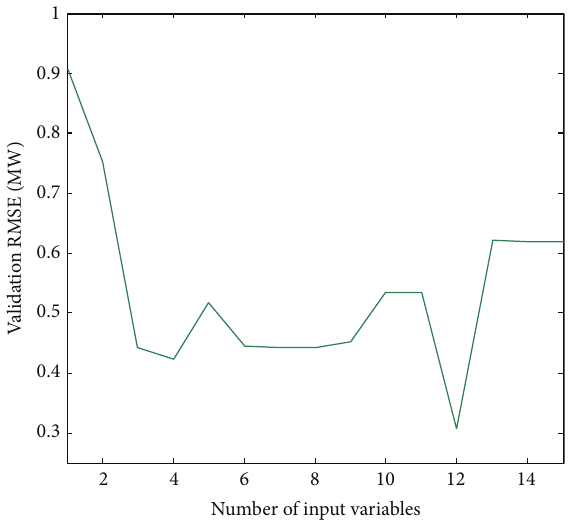
Figure 5: Validation error versus number of input variables (first day of April 2010).